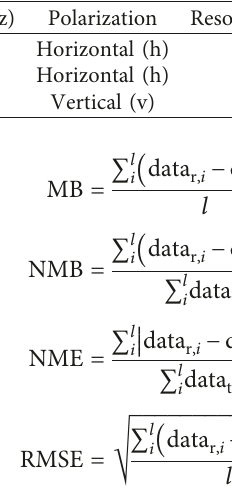
Figure 3: Flowchart of the retrieval using DFDP link. Table 3: Characteristics of the